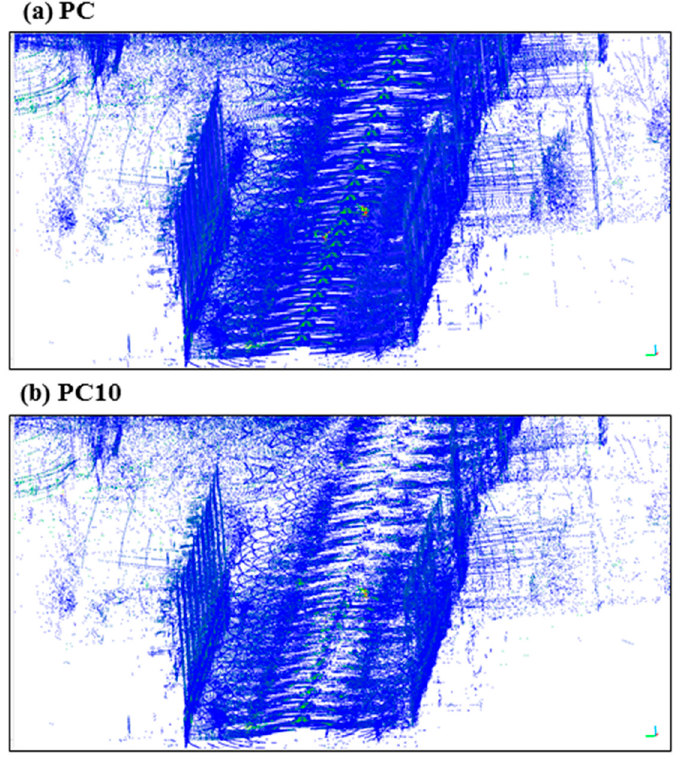
Figure 11. Example 2 of 3D point cloud: ( a ) original; ( b ) point cloud at 10% reduction level.